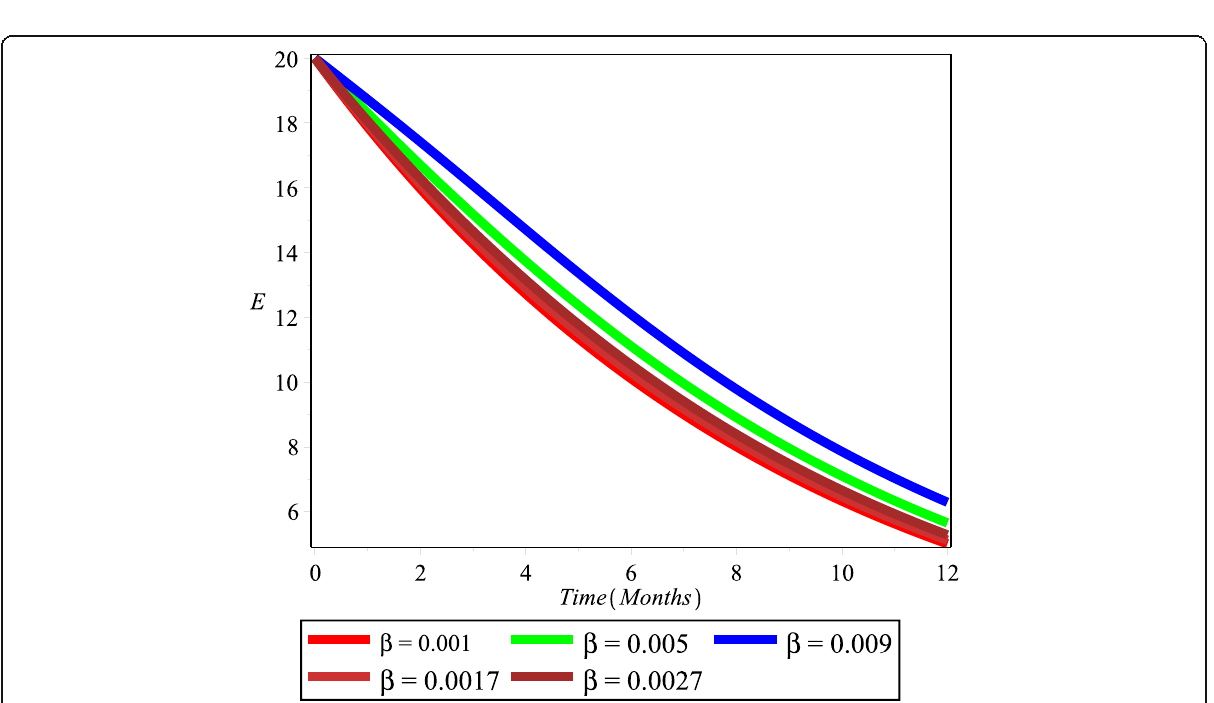
Fig. 11 Varying γ 1 (0.300 − 0.436) when R r >